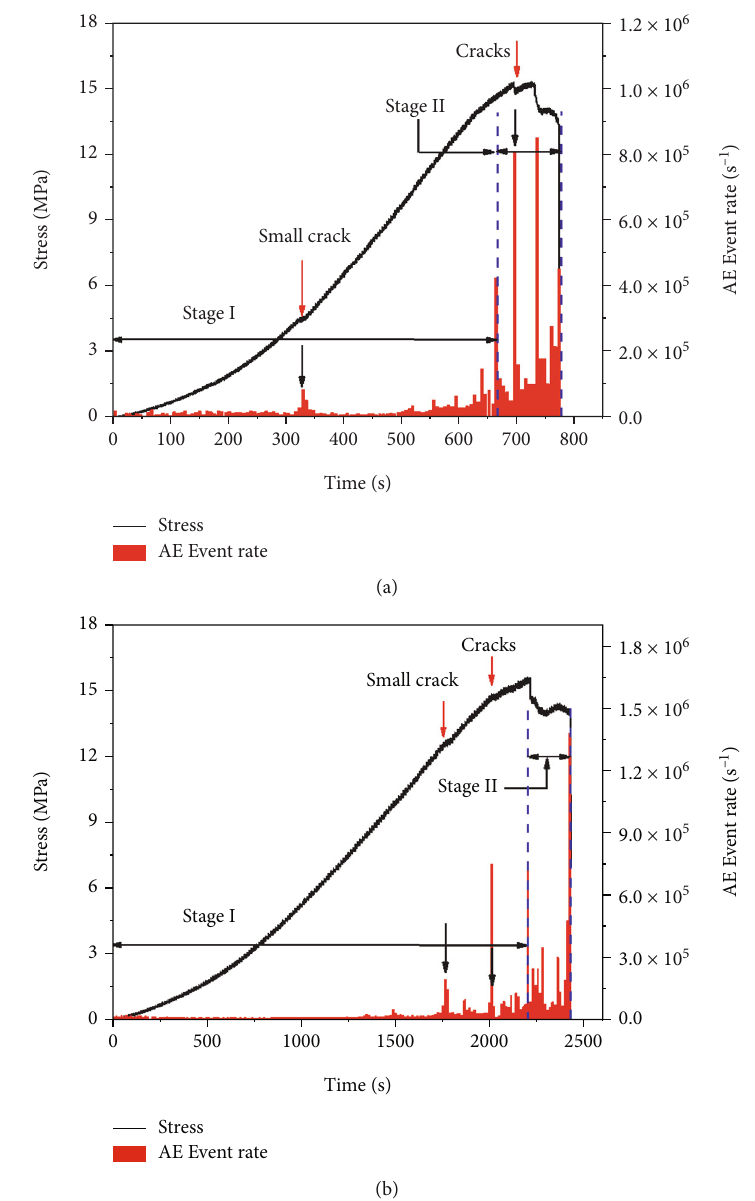
Figure 3: The evolution characteristics of AE signals. (a) The result of specimen R1. (b) The result of specimen